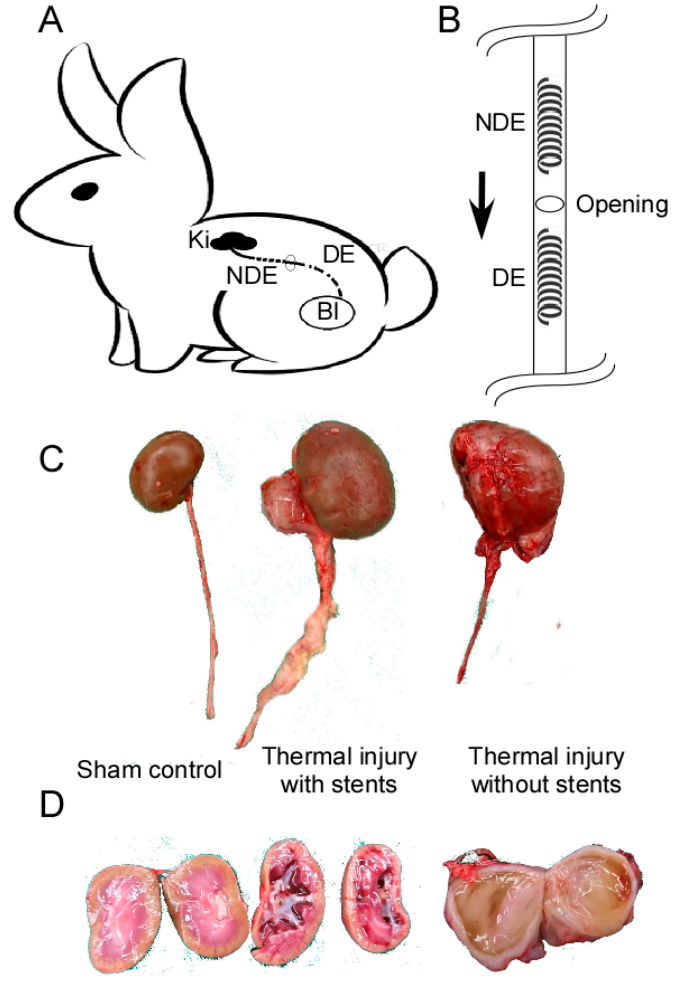
Figure 2. Operation method ( A ). Retroperitoneal space in the paraspinal region was dissected. Ureteral stents were inserted through the mid-ureteral opening. ( B ). In thermal injury with the stents group, a non-drug-eluting stent (NDE) was inserted in the upper ureter near the kidney (Ki), while a drug-eluting stent (DE) was inserted in the distal ureter near the bladder (Bl). The eluted drug may affect the distal ureter segment more due to urine flow direction (arrow). ( C ). Gross appearance of the kidney and ureter after 4 weeks of wound healing in sham control, thermal injury with stents, and thermal injury without stents. ( D ). Collecting system appearance in sham control, thermal injury with stents, and thermal injury without stents groups. The mild dilated renal pelvis can still be noted in the collecting system of the stented ureter. Prominent hydronephrosis if no stent was inserted after thermal injury.